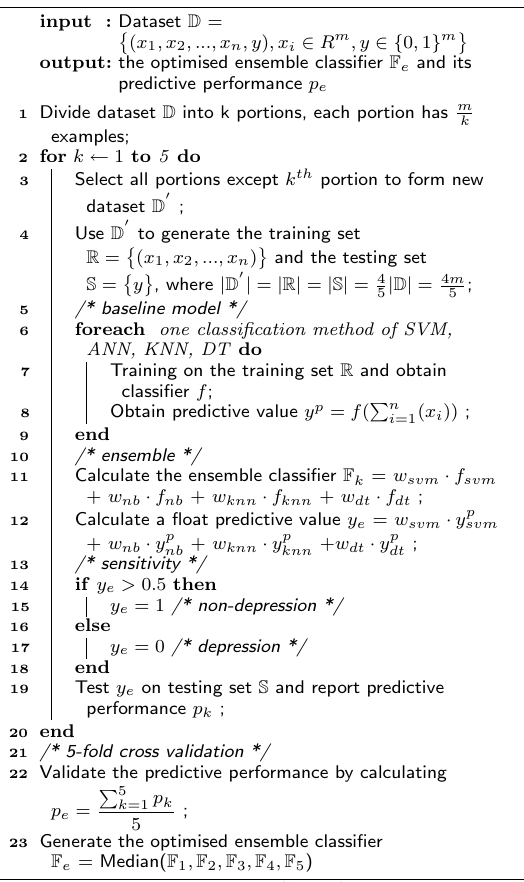
Algorithm 3: Ensemble Classification Proce-